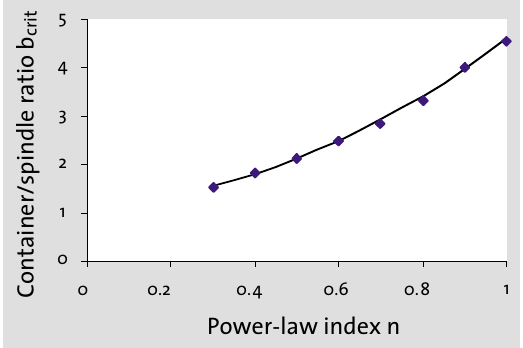
Figure 10: The ratio of the container-to-cylinder diam- eters at which the shear rate becomes virtually indepen- dent – to within 5% - of con- tainer size, plotted for vari- ous values of power-law index.